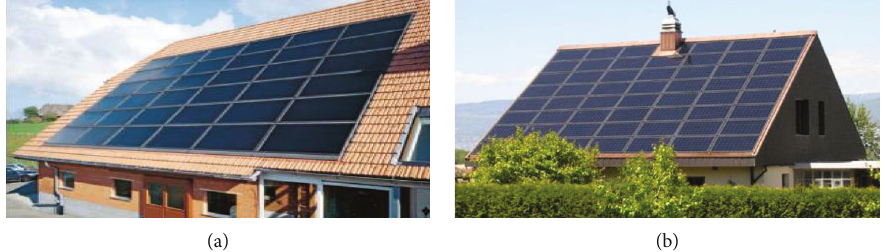
Figure 3: BIPV installation: (a) framed in-roof system — less homogenous appeal is due to the contrast of the aluminum frame and PV panels; (b) MegaSlates ’ full-roof BIPV installation on a house [45].